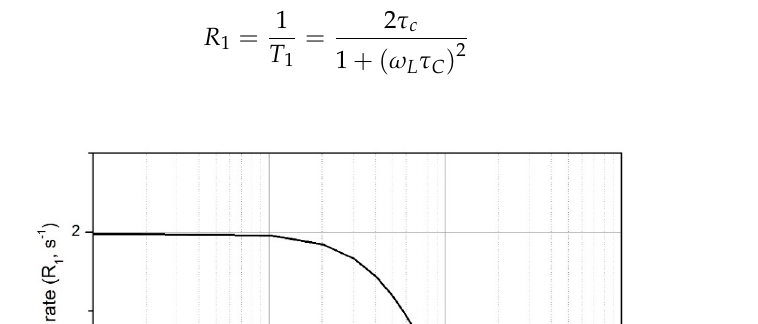
Figure 7. Typical sigmoidal shape of a nuclear magnetic resonance dispersion (NMRD) profile.